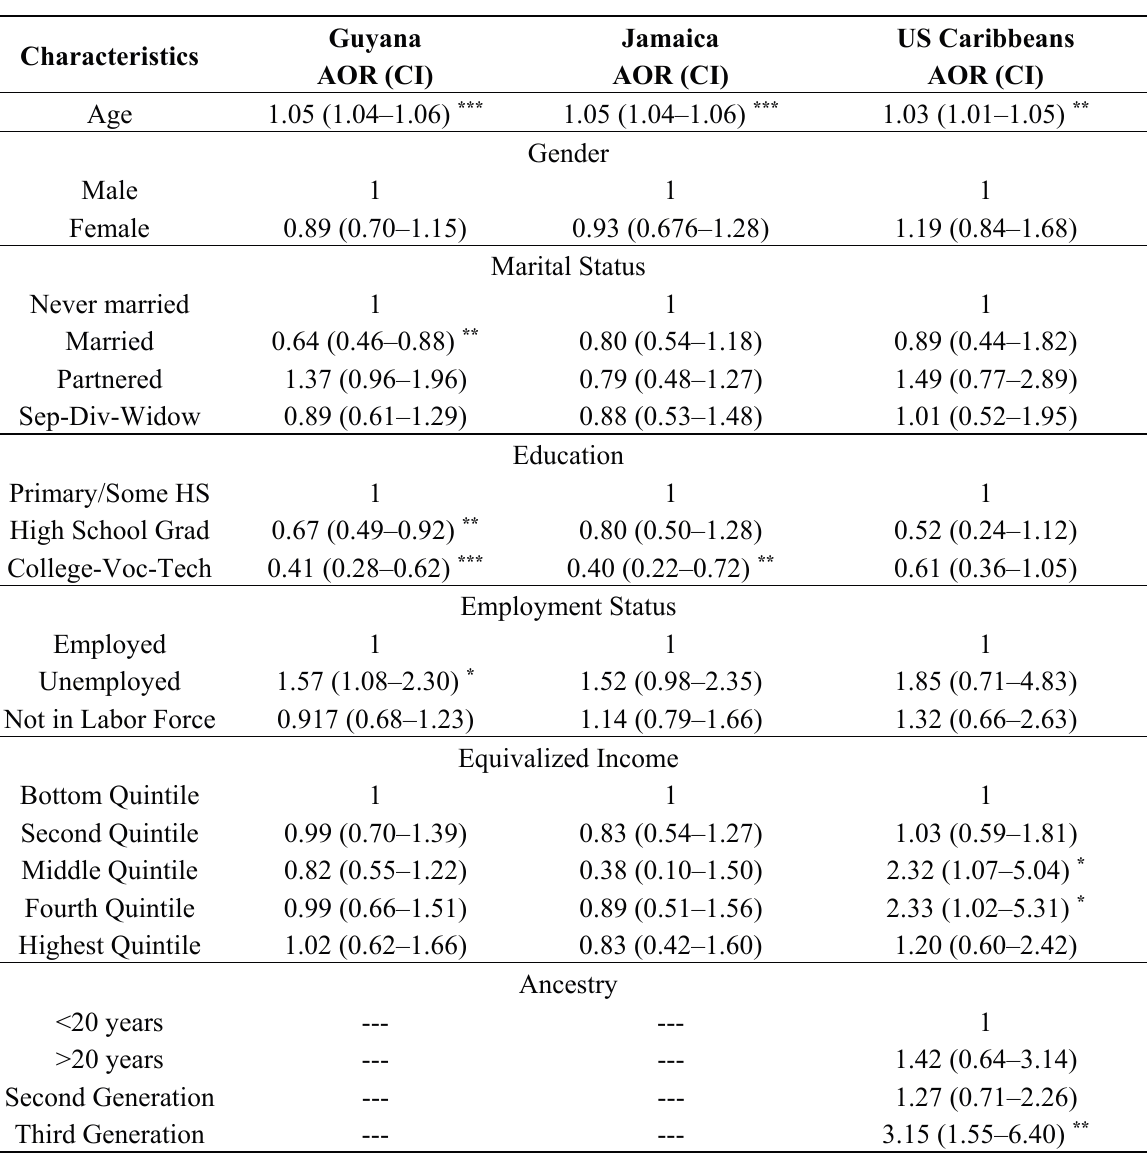
Table 9. Factors associated with self-rated dental health (fair/poor) by